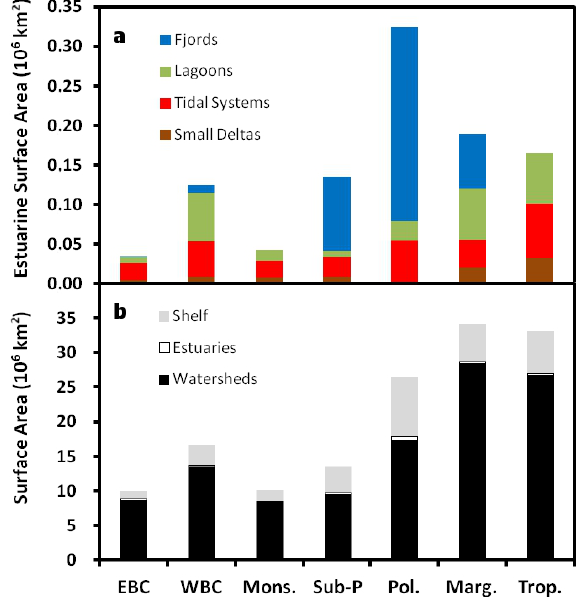
Fig. 4. Integrated surface areas for each MARCATS class of the dif- ferent estuarine types (a) and watersheds, estuaries and continental shelf (b)